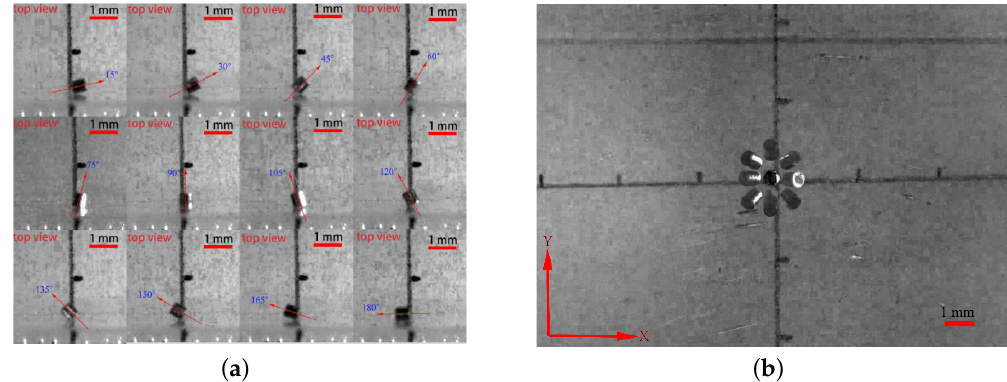
Figure 8. Demonstration of rotation control. ( a ) The magnetic carrier rotates around the Z -axis at the coordinate point (0, 0, 0), and the rotation amplitude is 15 degrees each time. ( b ) The magnetic carrier enable more complex spatial rotational motion. The direction of the magnetic moment of the magnetic carrier is 45 degrees from the Z -axis, and the circular rotation around the Z -axis is performed at coordinates (0, 0, 0).